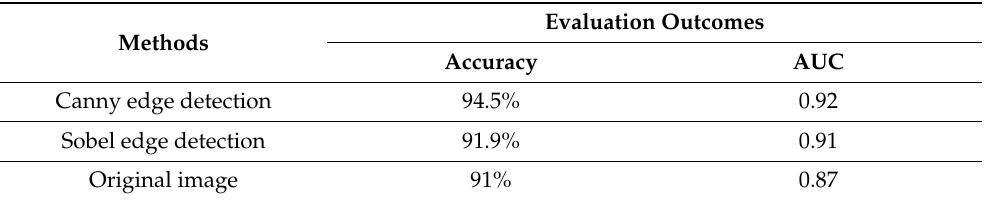
Table 2. Anomaly detection performance by pre-processing